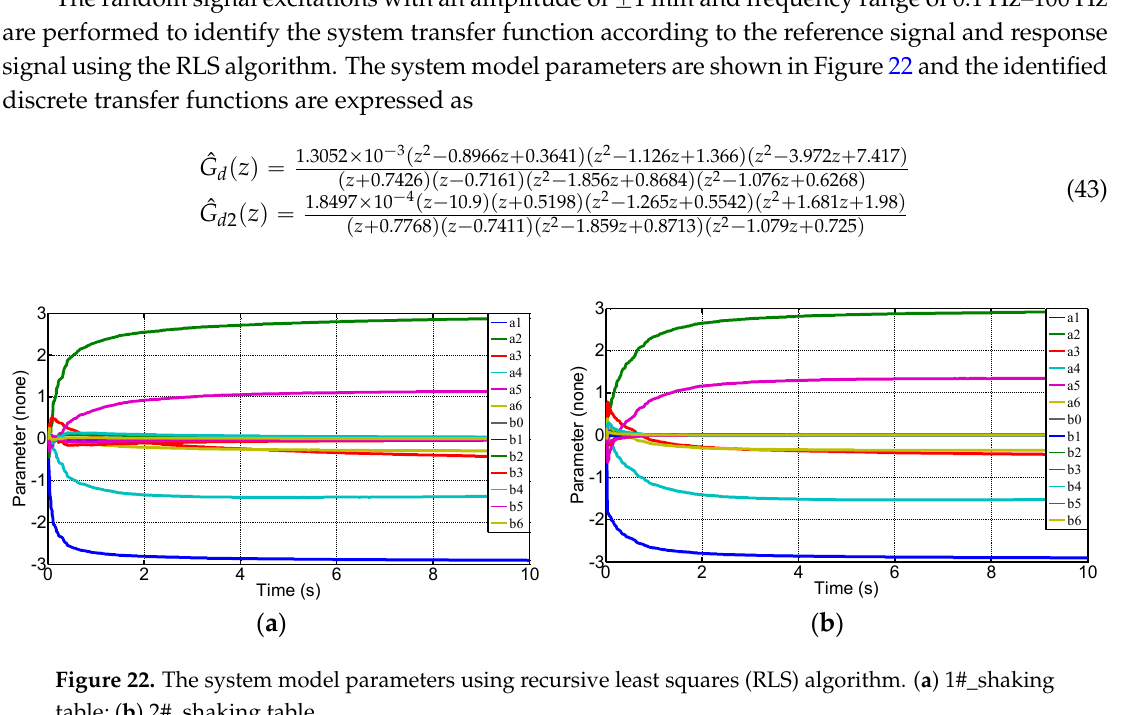
frequency characteristics; ( b ) Phase frequency characteristics.